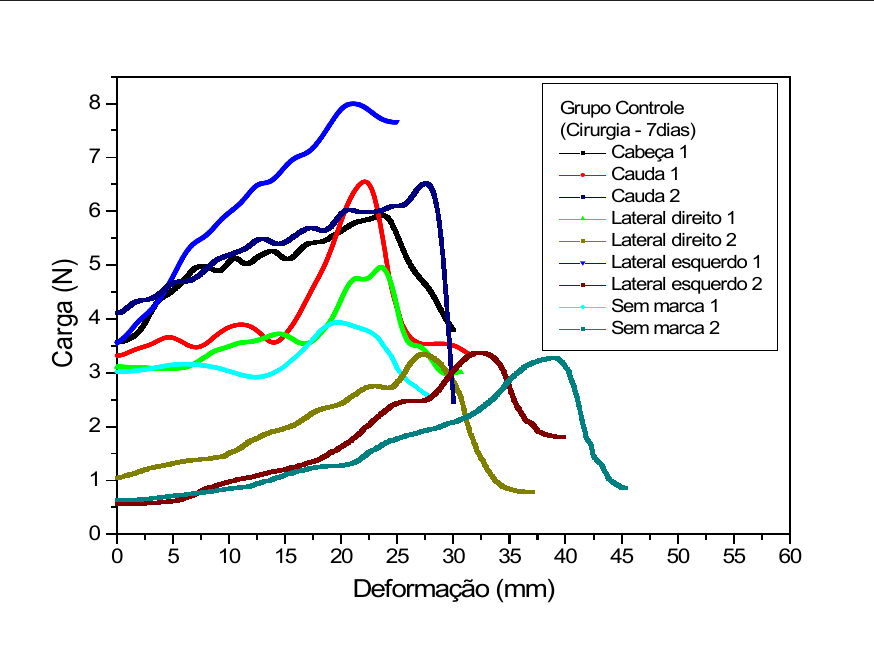
FIGURA 14 – Curva de carga versus deformação no grupo controle sete dias